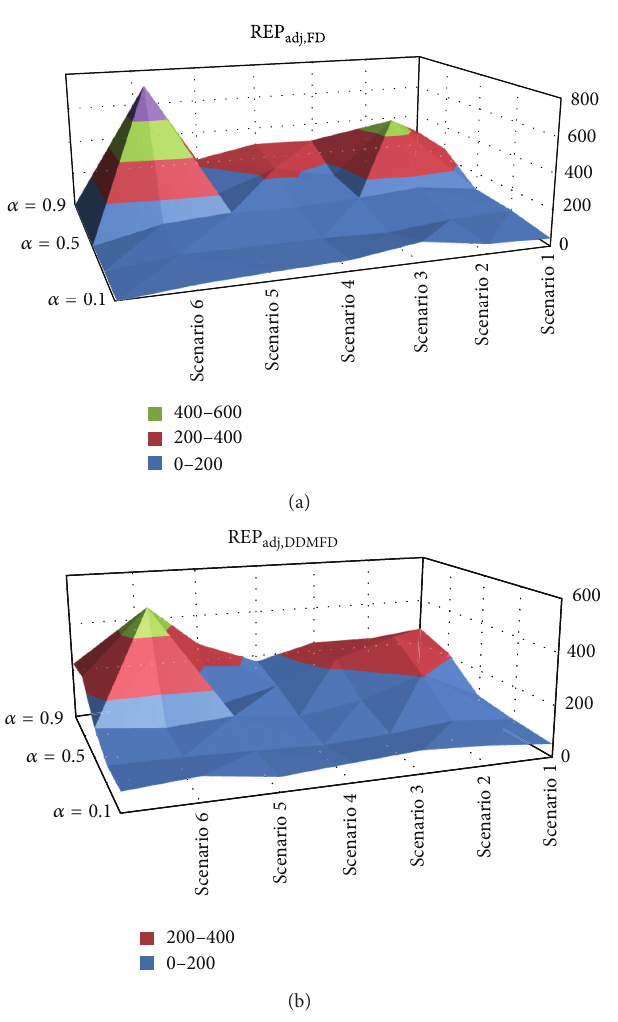
Figure 14: REP respect to speed parameter.